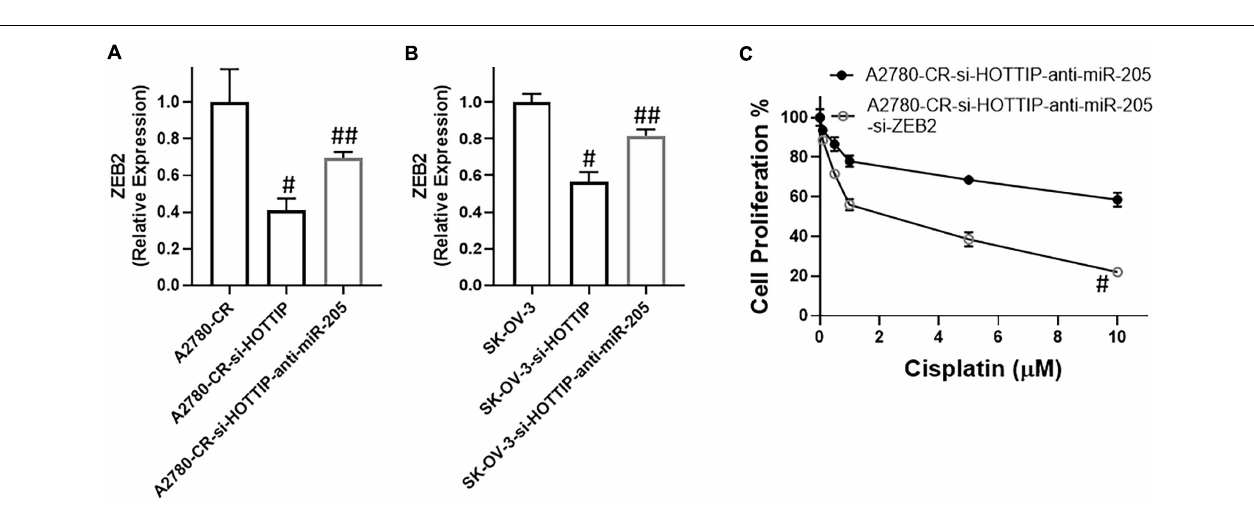
FIGURE 4 | (A) NF-kB assay for cisplatin resistant A2780-CR with and without pre-miR-205 and (B) NF-kB assay for HOTTIP silenced A2780-CR cells with and without anti-R-205, was performed using commercial kit. (C) Expression levels of stem cell makers (SOX2, OCT4 and NANOG) in HOTTIP silenced A2780-CR cells with and without anti-miR-205 and in (D) cisplatin resistant A2780-CR with and without pre-miR-205, as determined using a PCR. # p < 0.05.